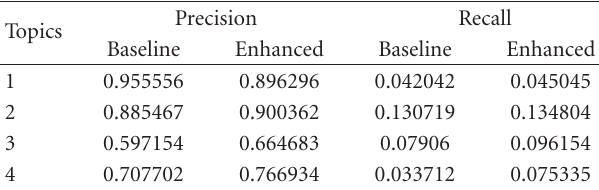
Table 3: Precision and Recall for the Baseline and Enhanced